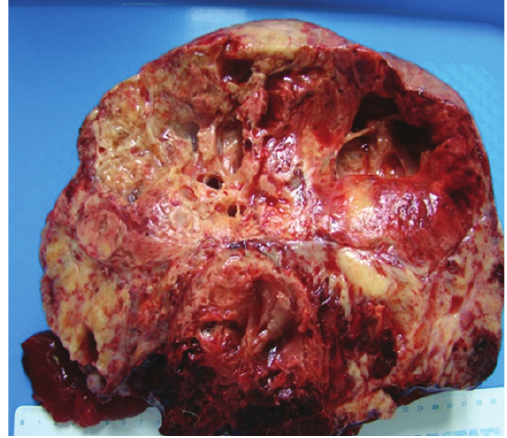
Figure 1: Macroscopic appearance of the cystic and solid mass with necrotic and hemorrhagic aspect.